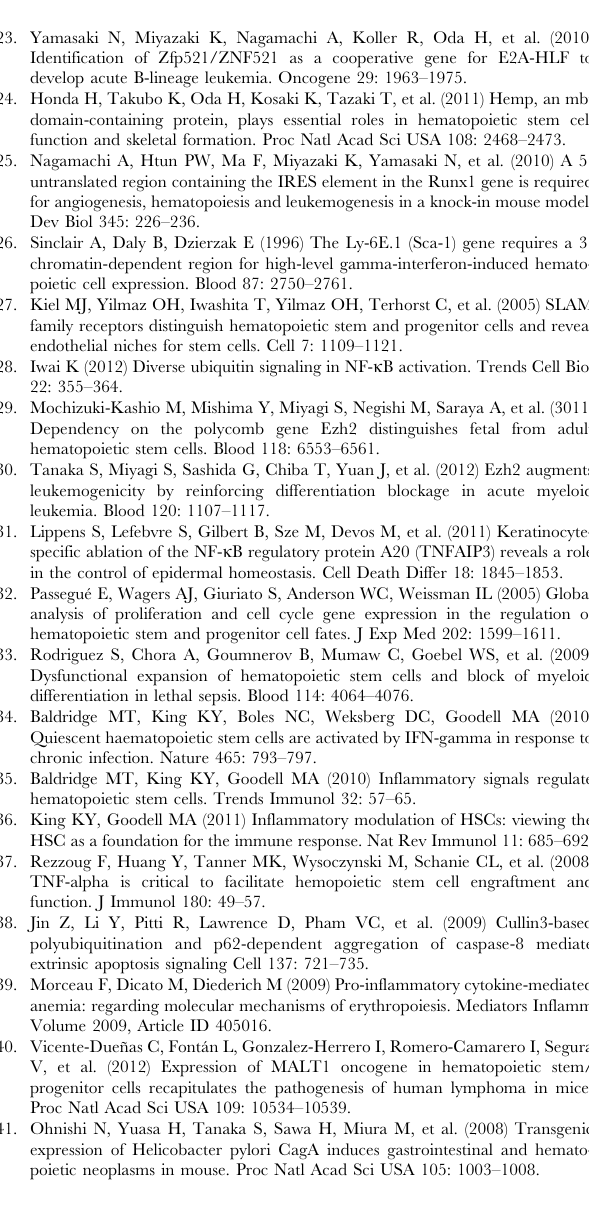
Table S1 Antibodies. All the antibodies used in this study are listed. (PDF) Table S2 Characteristics of A20Mx mice. Hematopoietic parameters of moribund A20Mx mice are described. (PDF) Text S1 Construction of a targeting vector and gener- ation of A20 knockout mice. Detailed procedure of Construc- tion of a targeting vector and generation of A20 knockout mice is described.